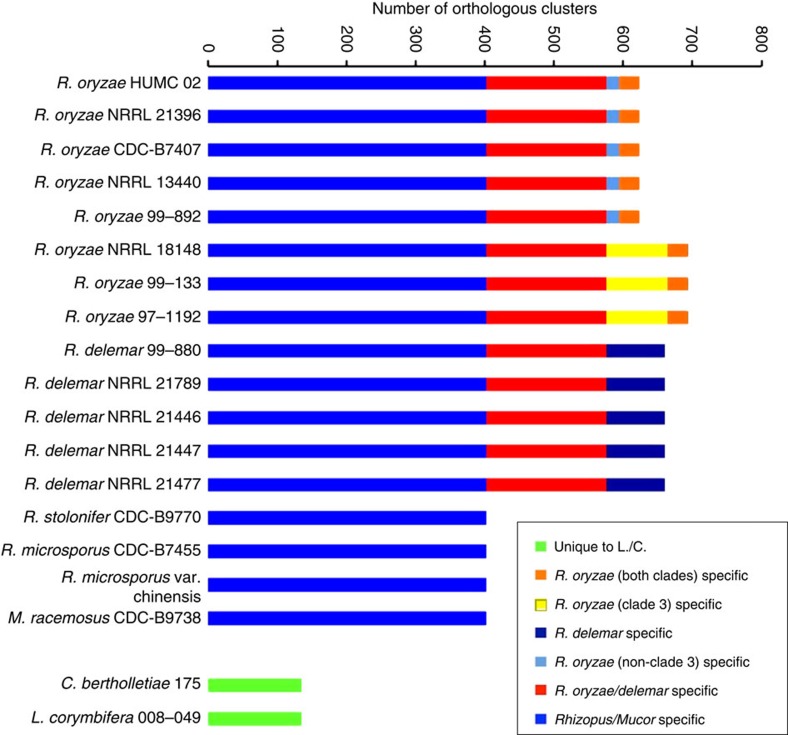
Identification of orthologous clusters.A bar plot of orthologous gene clusters in a subset of 19 Mucorales fungi. Core genes found in all 17 Rhizopus and Mucor strains are shown in blue, R. delemar/oryzae-specific genes are shown in red. Please refer to key for other classifications.